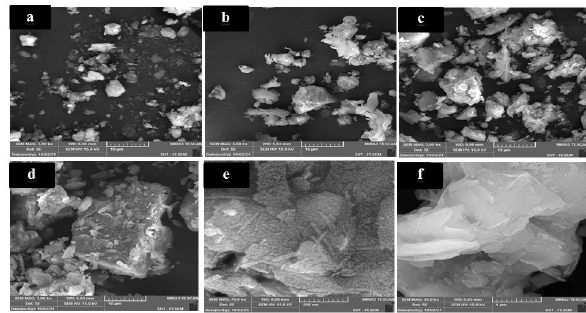
Figure 6: SEM confirm the presence of biomineralized crystal forma- tions as a result of MICP (a) soil before treated, (b) lead polluted soil with Cementation reagent, (c, d, e, f) lead polluted soil treated with bacterial solution and Cementation reagent